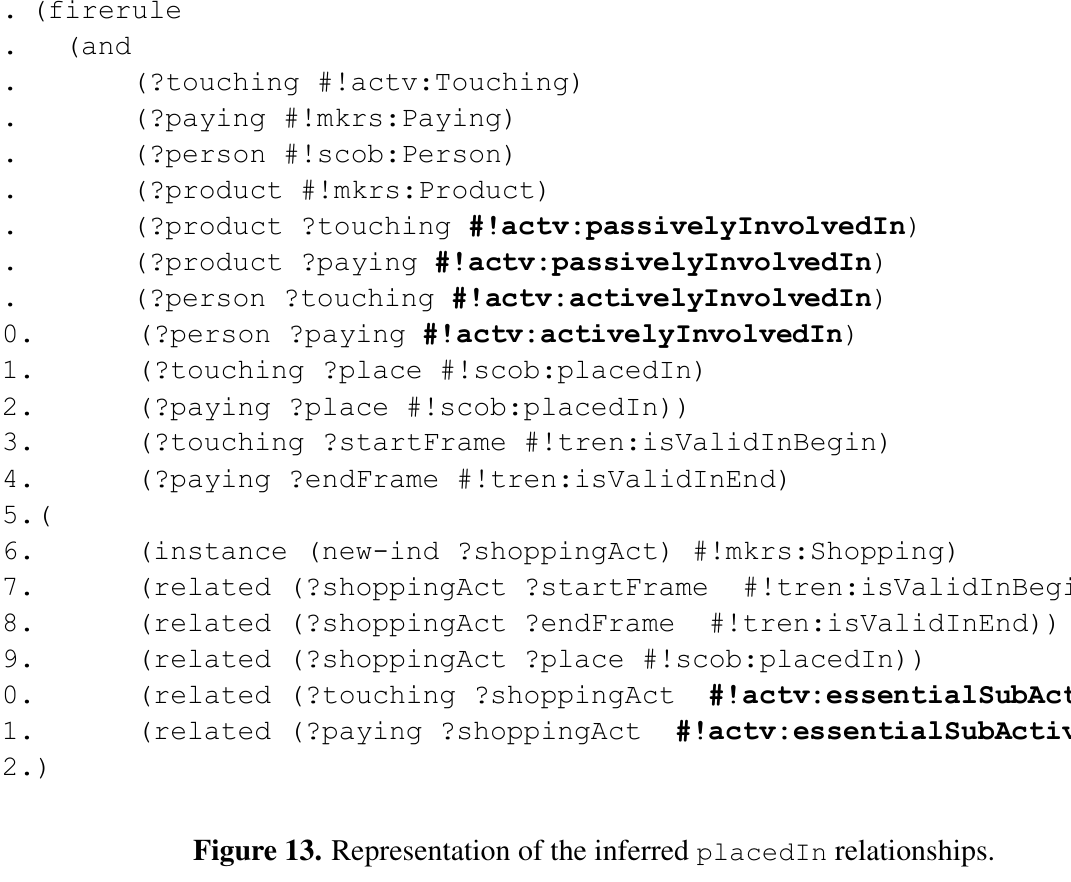
Figure 13. Representation of the inferred placedIn relationships.